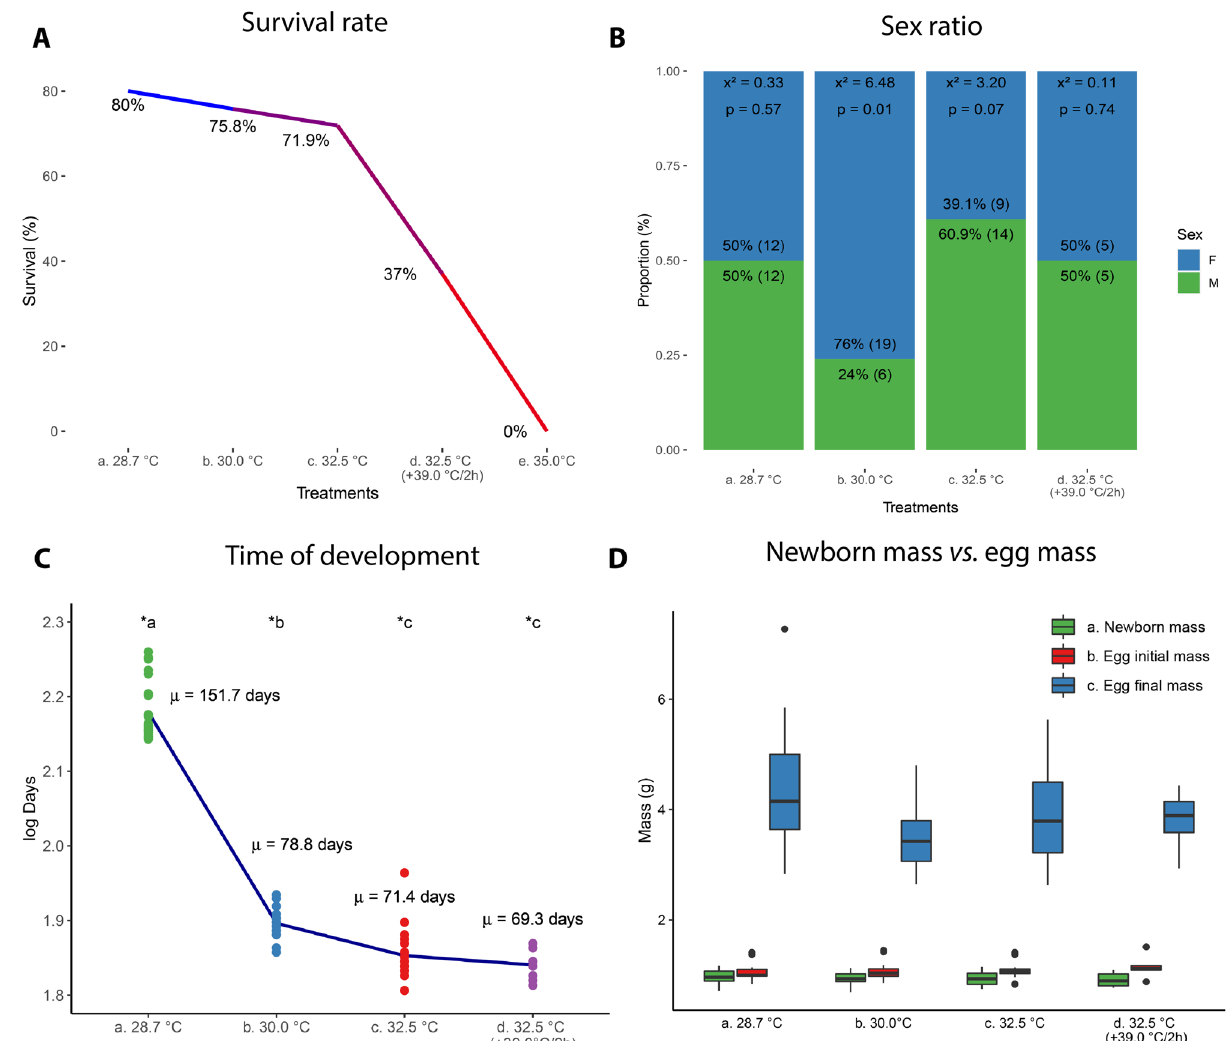
Figure 2. Incubation temperature effect on: ( A ) survival rate; ( B ) sex ratio; ( C ) development time, and ( D ) egg mass of Tropidurus torquatus under four incubation temperature